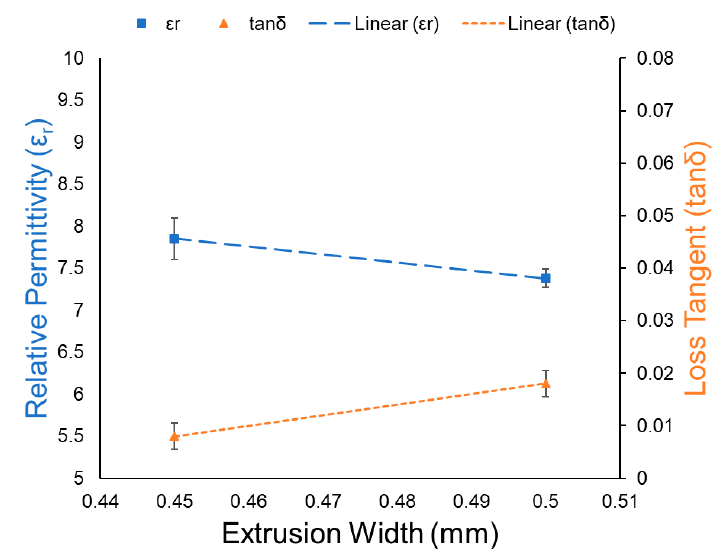
Figure 5. The effect of extrusion width (mm) vs. relative permittivity ( ε r ) and loss tangent ( tan δ ).